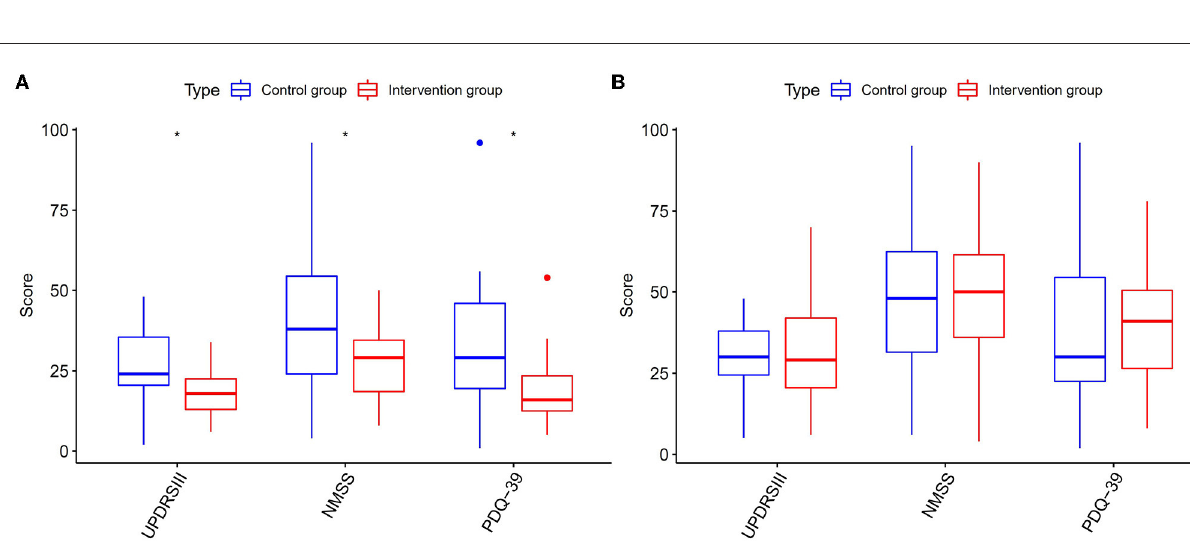
FIGURE2 Multi-evaluation score (UPDRS III, NMSS, and PDQ-39) of PD status. Intervention group: QHN group. Control group: SA group. (A) The evaluation scores before treatment between two groups. (B) The evaluation scores after treatment between two